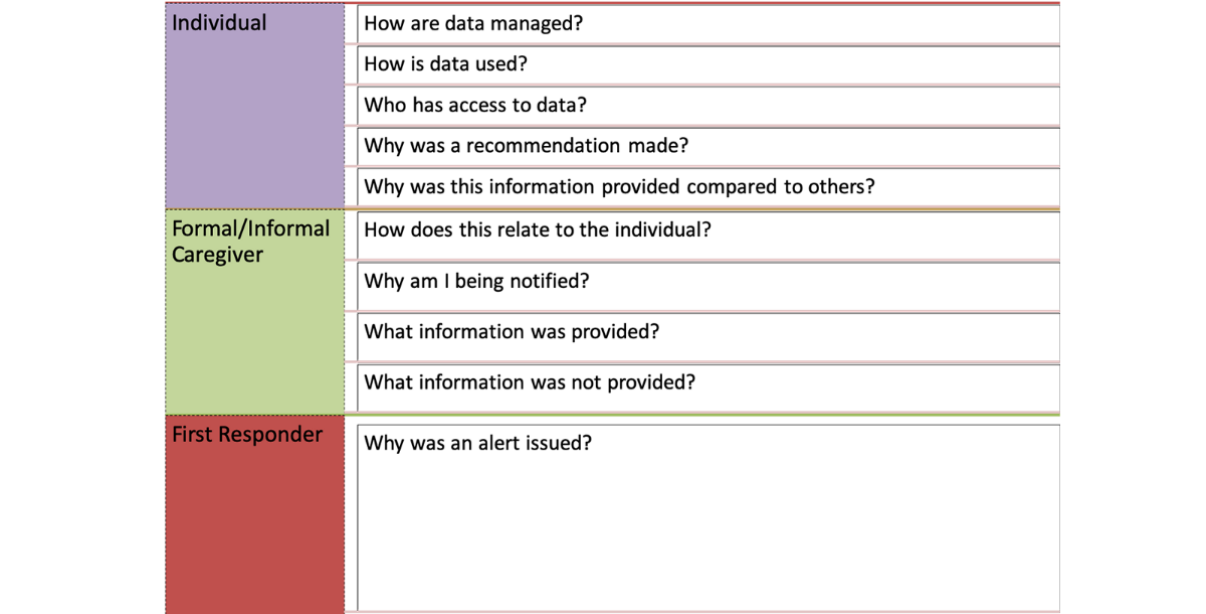
Figure 4. Example of questions to improve the transparency of system actions for older adult users and those involved in their